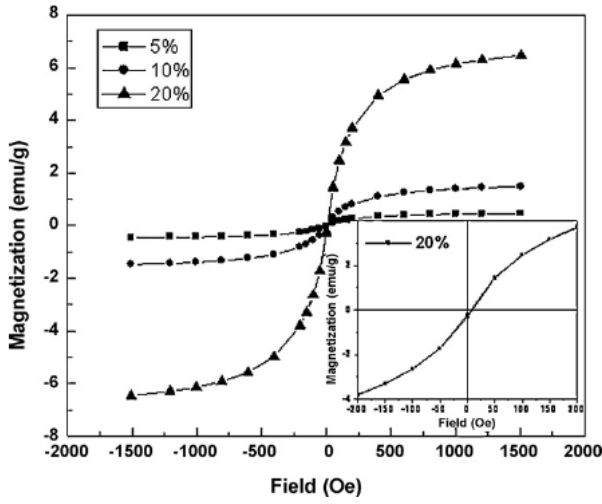
O content (adapted from Ref. 3 4